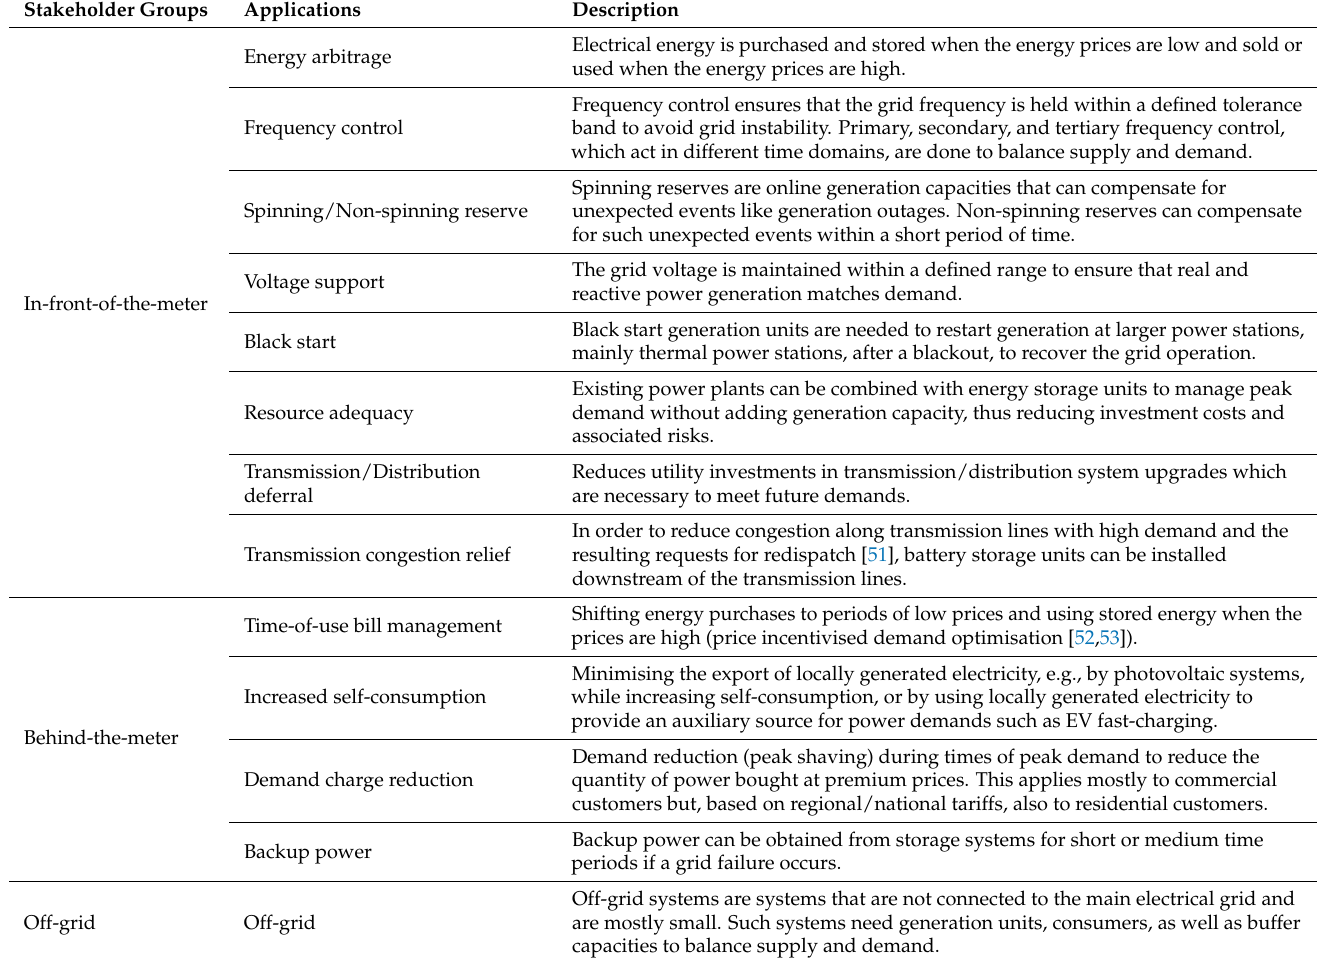
Table 1. Stakeholder groups and corresponding application areas